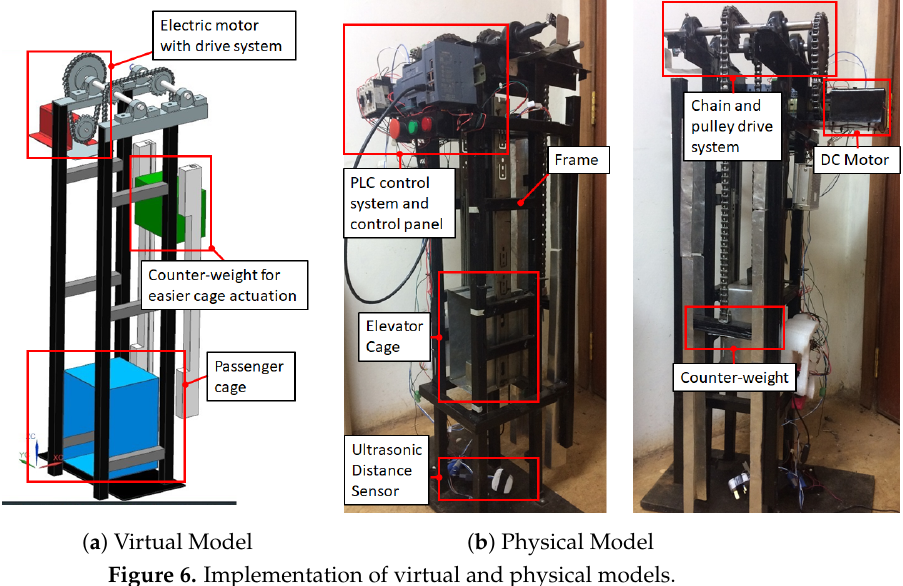
Figure 6. Implementation of virtual and physical